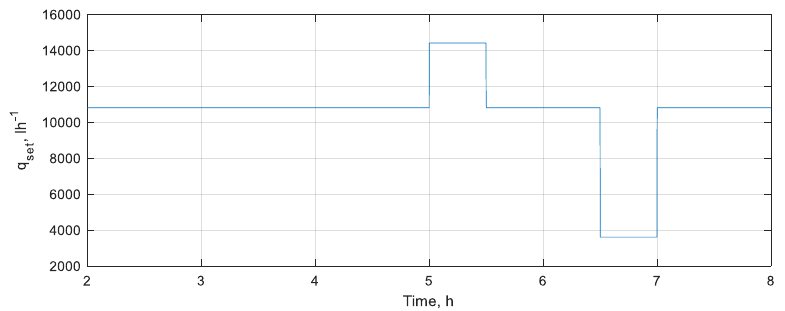
Figure 5. Air supply rate change during the simulation.